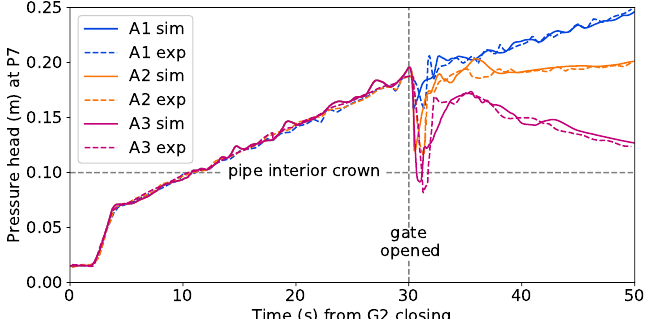
Figure 3. Pressure head at P7 for simulations and experiments of Cases A1–A3.